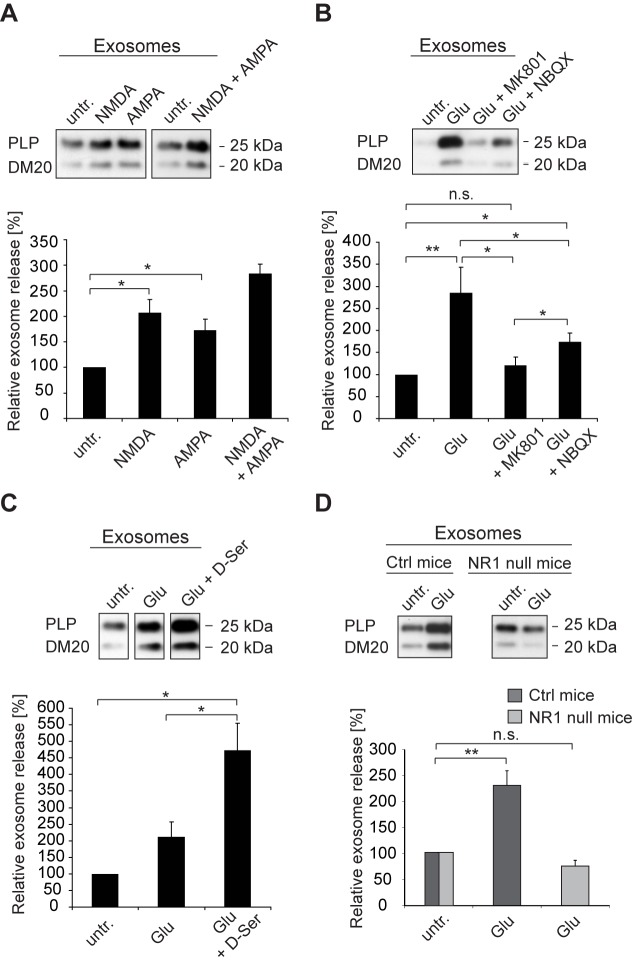
NMDA and AMPA receptors mediate exosome release.Quantification of exosome release upon (A) stimulation with glutamate receptor agonists NMDA (100 µM, n = 7), AMPA (100 µM, n = 5), or NMDA and AMPA (n = 4), (B) application of NMDA and AMPA receptor antagonists MK801 (5 µM, n = 9) or NBQX (25 µM, n = 9), or (C) the NMDA receptor co-agonist D-Serine (100 µM, n = 5). (D) Glutamate-stimulated exosome release from NMDA receptor-deficient oligodendrocytes obtained from CNPCre/+*NR1flox/flox mice (n = 6) compared to CNPCre/+ control mice (n = 9). Representative Western blots of PLP in exosome pellets are depicted. Error bars, SEM (n.s., not significant ; * p<0.05; ** p<0.01; Wilcoxon test).